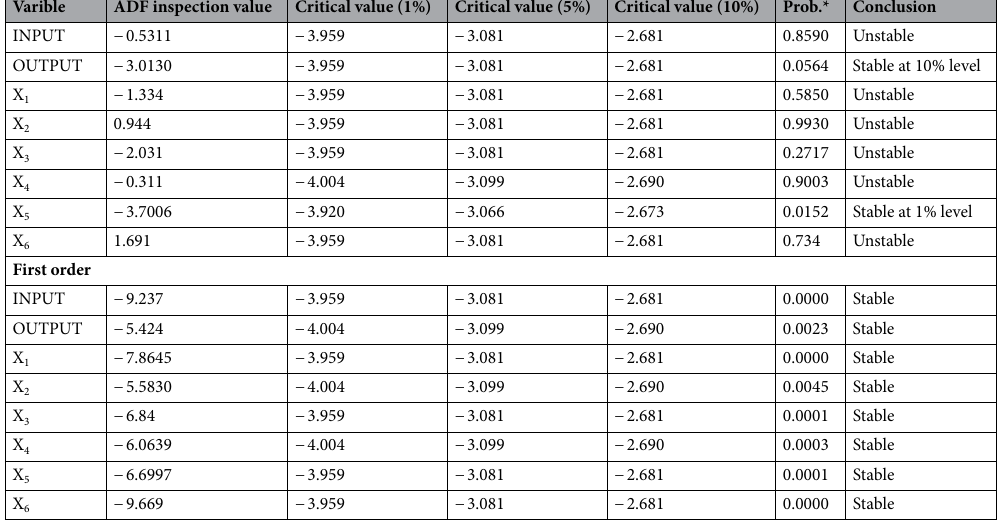
Table 6. ADF test results.